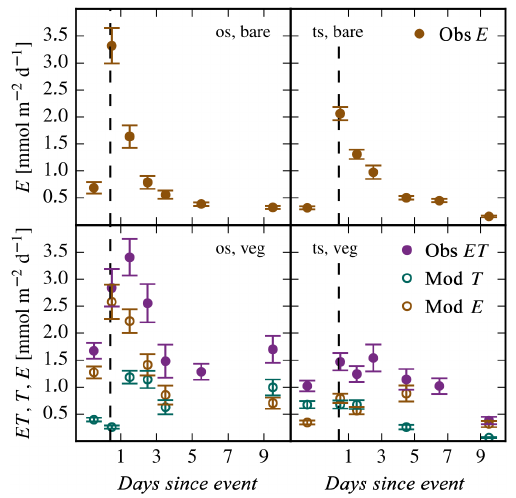
Figure 5. Mean daily flux rates of soil evaporation E , plant transpi- ration T , and combined evapotranspiration ET from bare-soil (bare) or vegetation plots (veg) at open sites between tree crowns (os) and shaded sites beneath tree crowns (ts). Filled dots represent observed values (obs); hollow dots represent modelled values (mod). Dashed lines mark time of watering event. Uncertainty bars display standard